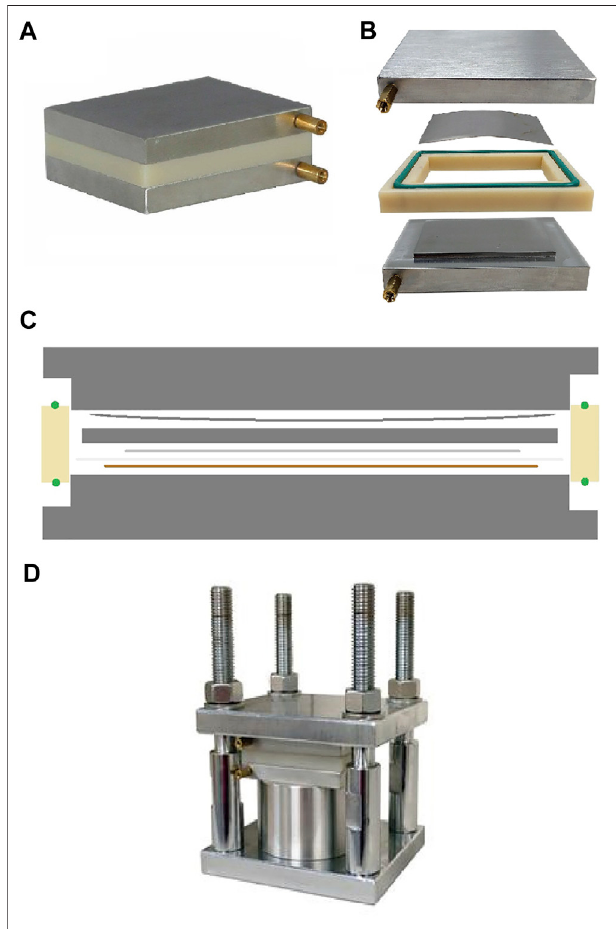
FIGURE 1 | (A) Split pouch cell used in this study. (B) expanded view of the split pouch cell without the spacers and Na||Cu cell. (C) Illustration of the Cross section of the split pouch cell, showing an example Na||Cu cell assembly. Bottom to top: bottom plate, PEEK chamber (with sealing ring),copper,separator, sodium, 3 mm spacer +(0, 1or 2) 0.5 mm spacer(s), wavespring,topplate(incontactwiththetopsealingring). (D) Splitpouchcell situated within the mechanical jig used to apply pressure. Images (A) , (B) and (D) are reproduced with permission of MTI Corporation.